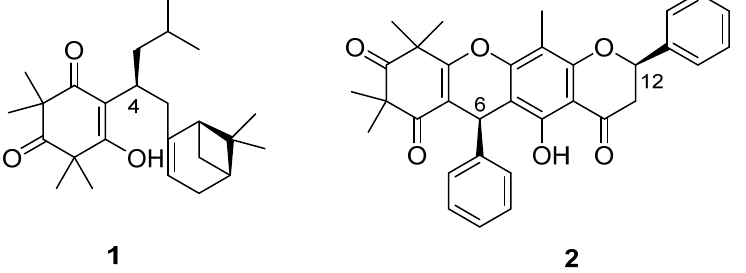
Figure 1. Structures of tomentosenol A (Compound 1 ; ( 1 )) and torellianone A (Compound 2 ; ( 2